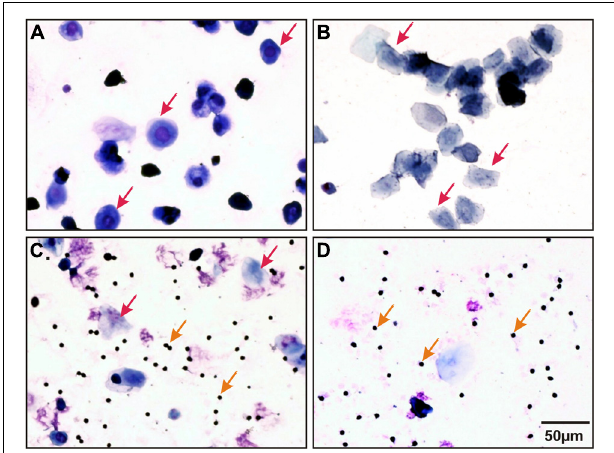
FIGURE 1 | Representative stained (methylene blue, toluidine blue, and hematoxylin) vaginal smears collected from a female Sprague Dawley (SD) rat illustrating all four stages of estrus cycle. (A) Proestrus: nucleated epithelial cells (indicated by red arrows); (B) Estrus: jagged edged (cornified) non-nucleate cells (indicated by red arrows); (C) Metestrus: many leukocytes (indicated by orange arrows) and a few cornified cells (indicated by red arrows) and (D) Diestrus: mainly leukocytes (indicated by orange arrows) and a few nucleated